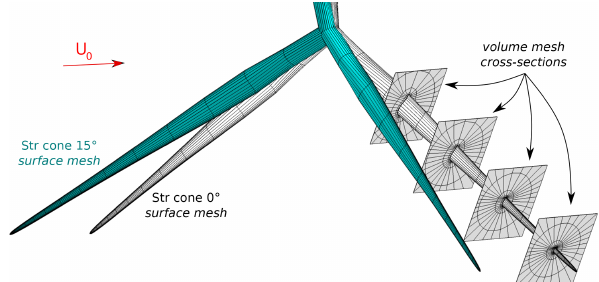
Figure 5. Detail of the surface mesh for the straight variants used in the fully resolved CFD simulations, showing two of the blades. Two different configurations are included, accounting for a cone angle of 0 and 15 ◦ . For the zero-cone-angle case, the topology of the volume mesh is shown through arbitrary cross-sectional cuts along the span. The free-stream velocity vector is U 0 . For clarity, only every eighth grid line is